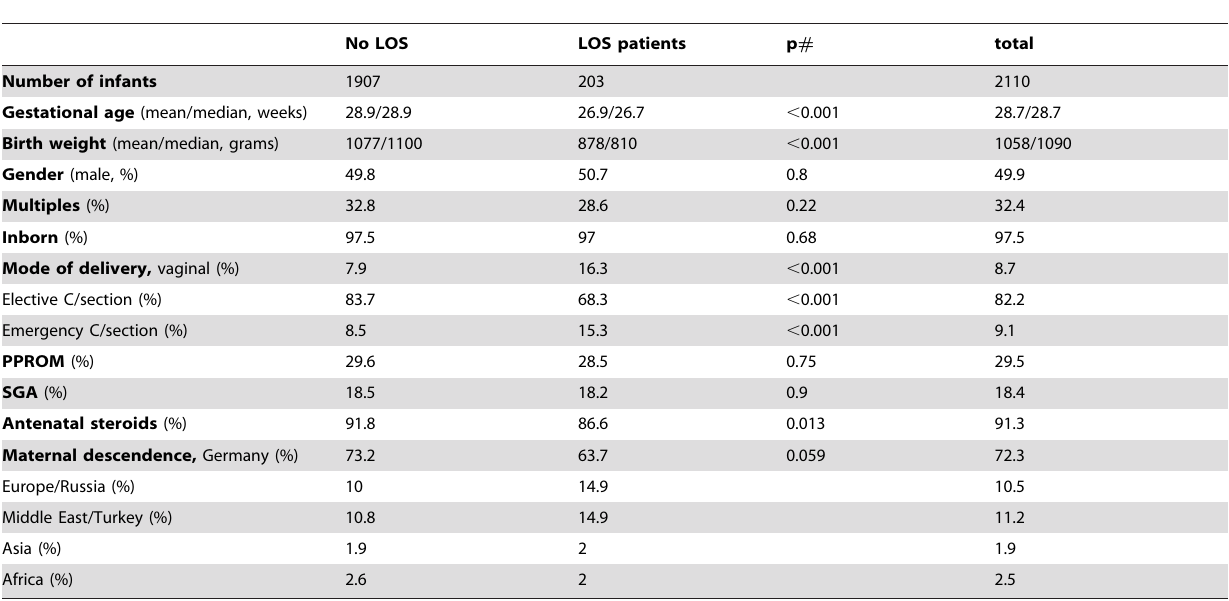
Table 1. Clinical characteristics of the VLBW cohort stratified to occurrence of late-onset sepsis (LOS).